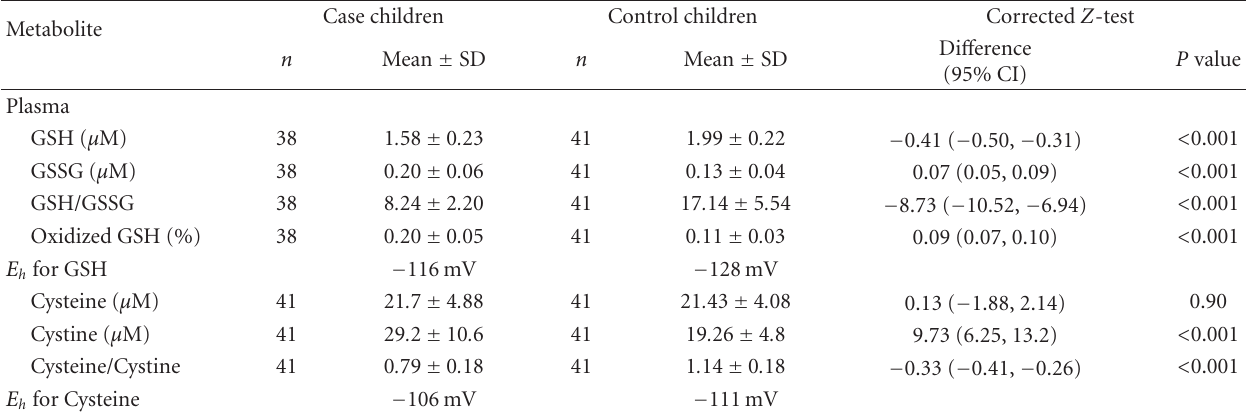
Table 3: Extracellular (plasma) glutathione and cysteine redox status.